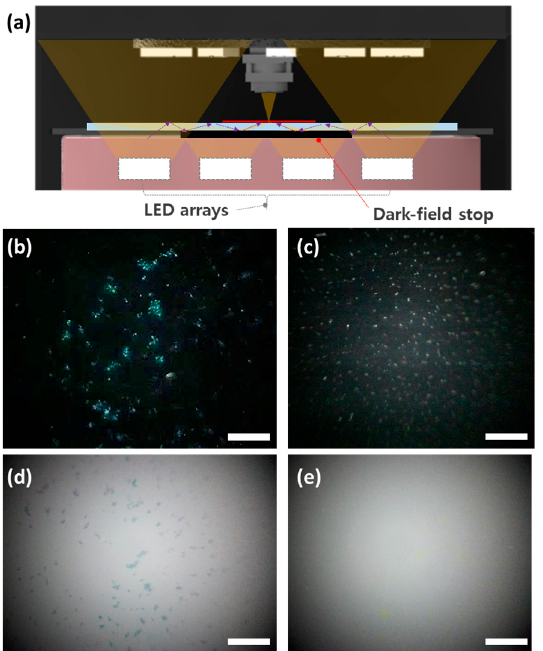
Figure 5. Microscopic imaging applications through the MCM. ( a ) A schematic illustration of dark ‐ field microscopic imaging. The captured dark ‐ field images of ( b ) yeast and ( c ) sugar through the MCM with the dark ‐ field stop. The captured bright ‐ field images of ( d ) yeast and ( e ) sugar through the MCM to compare with dark ‐ field images. The scale bars are 100 μ m.